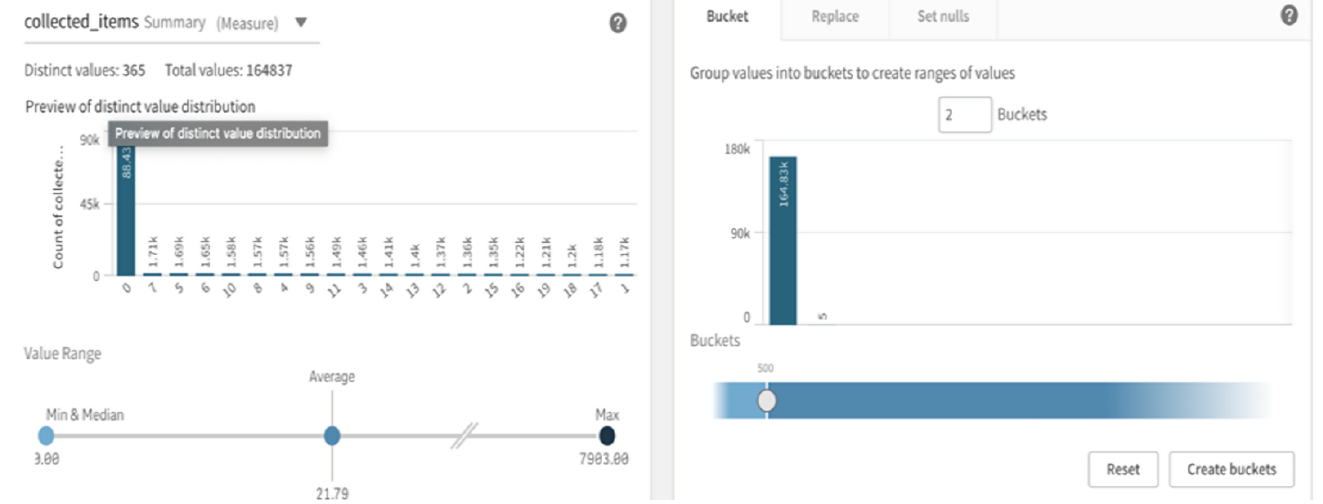
Figure 6. Data preparation screen for the Qlik Sense platform with the AA approach.